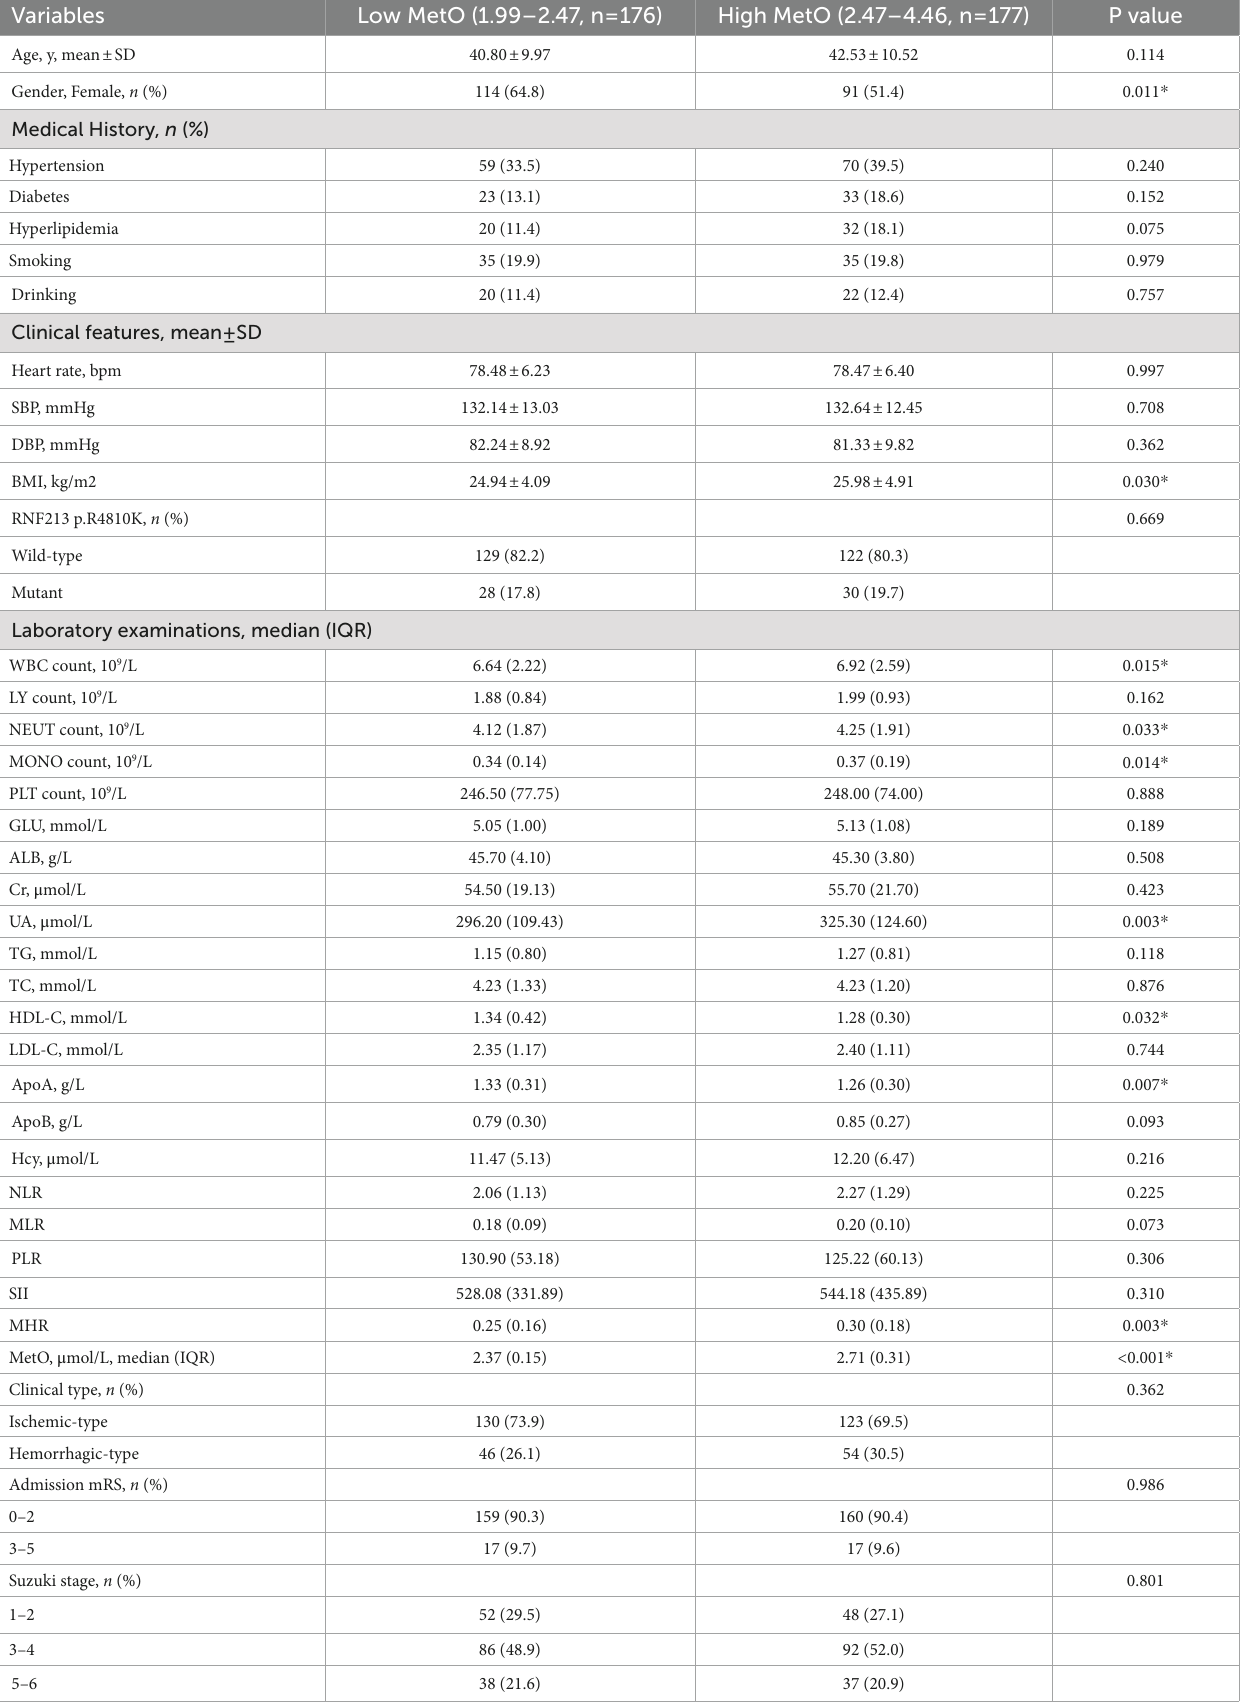
TABLE 3 Baseline characteristics of MMD patients between low and high MetO groups.